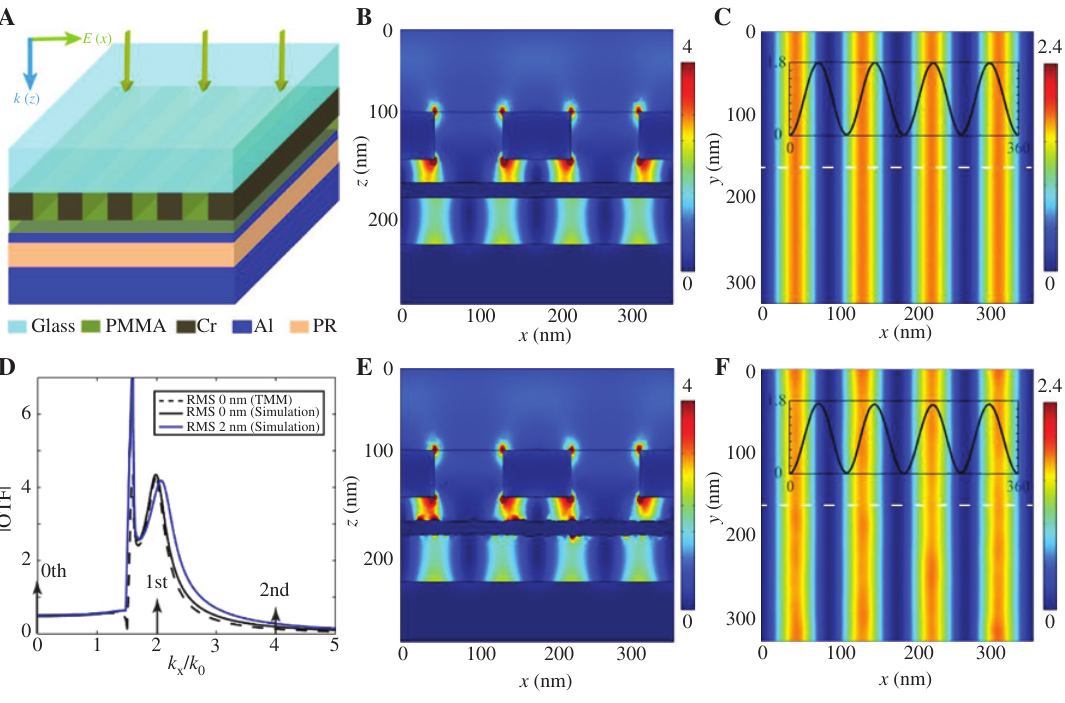
Figure 6: Effects of the rough film in waveguide lithography system. (A) Schematics of plasmonic lithography with the waveguide structure. (B) Side view and (C) top view of the normalized electric field inten- sity distributions with smooth Al film (RMS = 0 nm); (D) OTF curves of a single Al film with smooth and rough surface calculated by TMM and numerical simulation. Arrows show the positions of diffraction orders of the grating mask in k -space. (E, F) Corresponding simulation results with rough Al film (RMS = 2 nm). The inset pictures in (C) and (F) are the corresponding intensity distributions at the dashed line